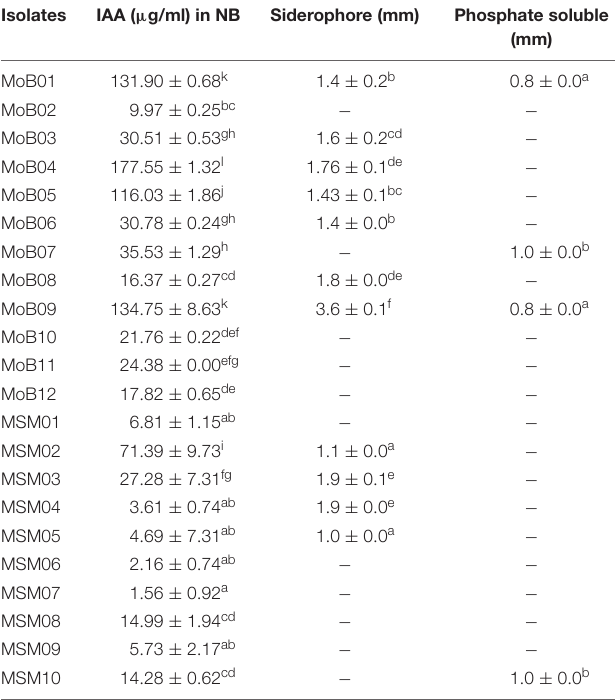
TABLE 1 | Plant growth-promoting abilities of bacterial